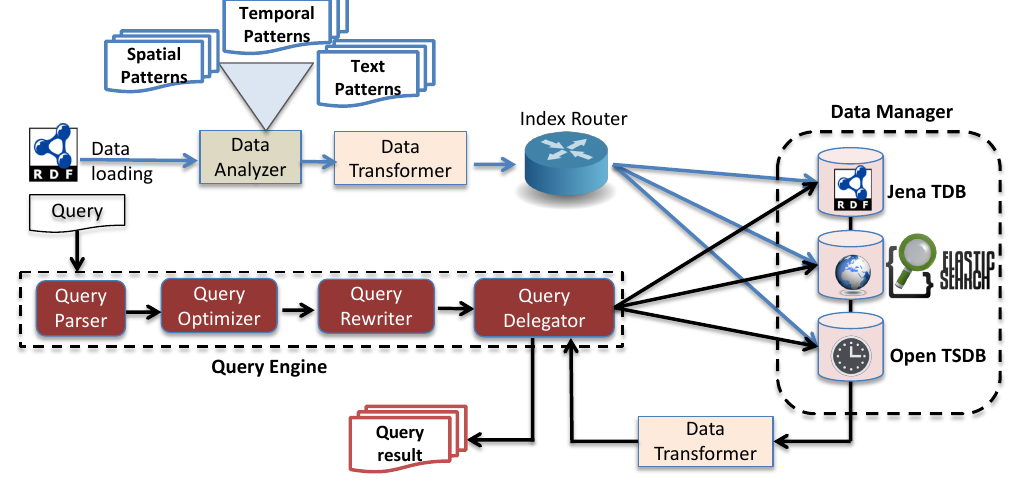
Figure 1. EAGLE’s